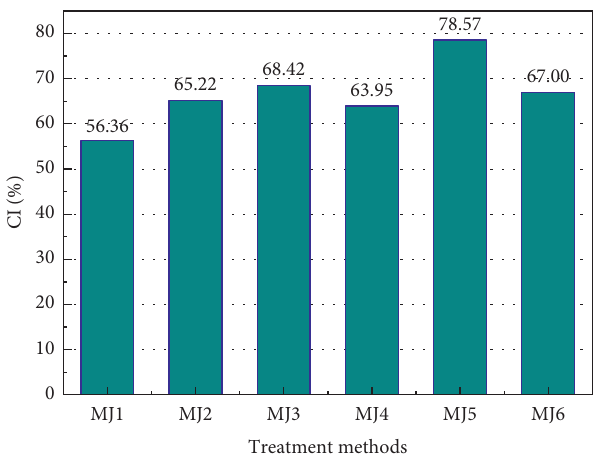
Figure 4: Crystallinity of wheat straw fibers before and after